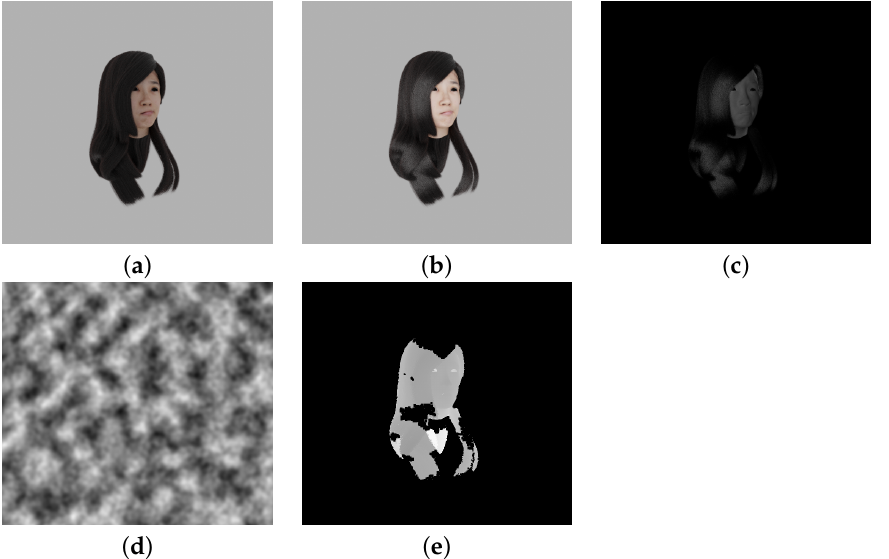
Figure 1. Reproduction of missing depth images in input point clouds. ( a ) color image; ( b ) lighted image; ( c ) difference image; ( d ) Perlin noise; ( e ) reproduced missing depth image.